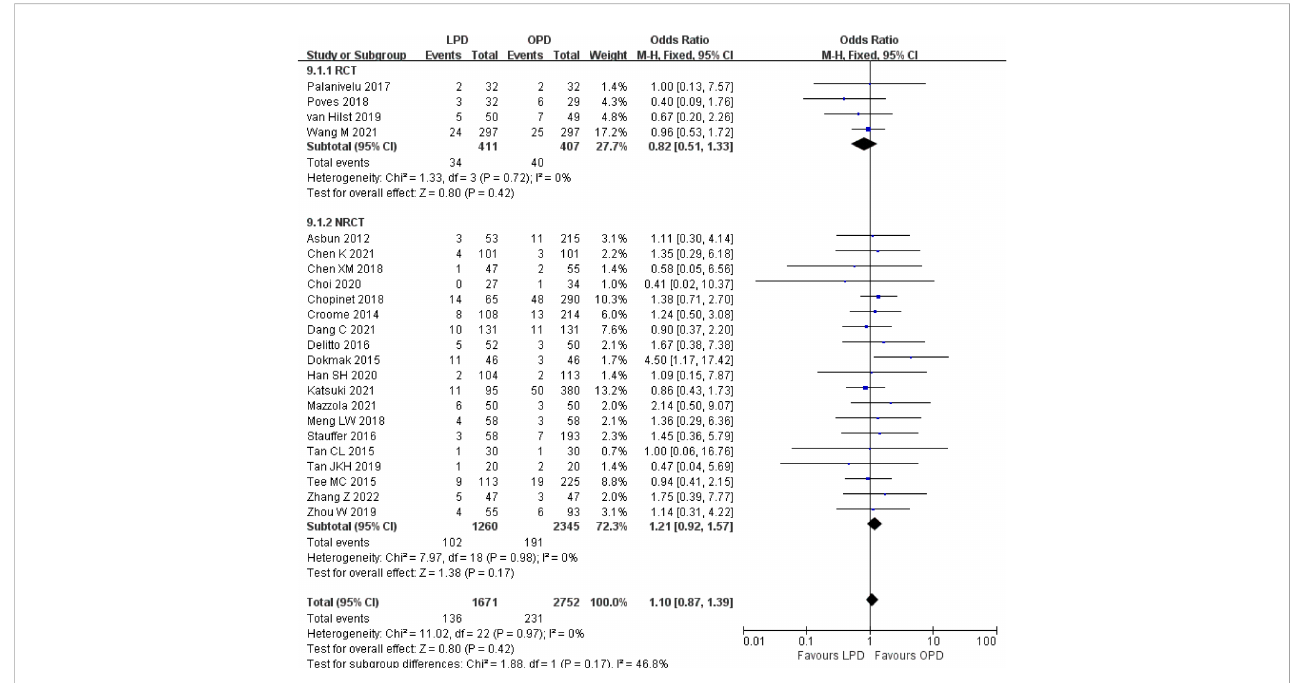
FIGURE 9 Forest plot of comparison between LPD and OPD on postpancreatectomy hemorrhage. LPD, laparoscopic pancreaticoduodenectom; OPD, open pancreaticoduodenectomy.